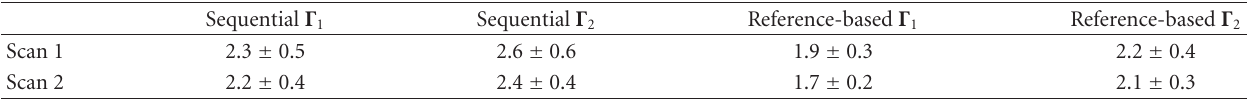
Figure 3: The virtual tag lines and the corresponding short-axis slices of the tagged MRI scan are shown over the cardiac cycle (first row: end diastole; third row: end systole) for (a) sequential recovery by Γ 1 , (b) sequential recovery by Γ 2 , (c) reference-based recovery by Γ 1 , and (d) reference-based recovery by Γ 2 . The registration algorithms Γ 1 and Γ 2 and the di ff erence between sequential and reference-based recovery are explained in Section 3.2. The virtual tag lines were manually positioned over the tagged MR image in the first frame (shown in the first row), and then the deformation recovered from the anatomical image sequence was applied to the virtual tag lines and they were overlaid over the tagged MR images in the corresponding frames. Table 2: The mean ( ± std) distance [mm] between corresponding intersections of virtual and real tag lines at end systole for the four algorithms for both scans.